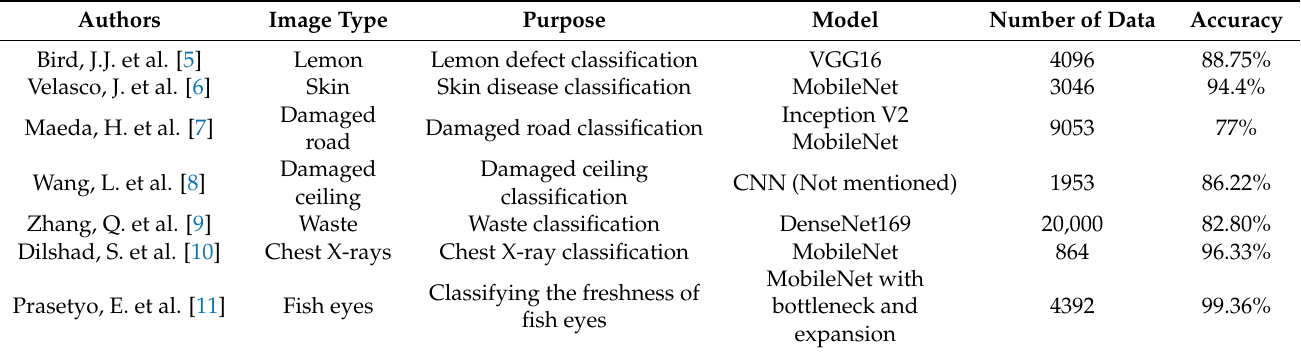
Table 2. Comparison of the literature